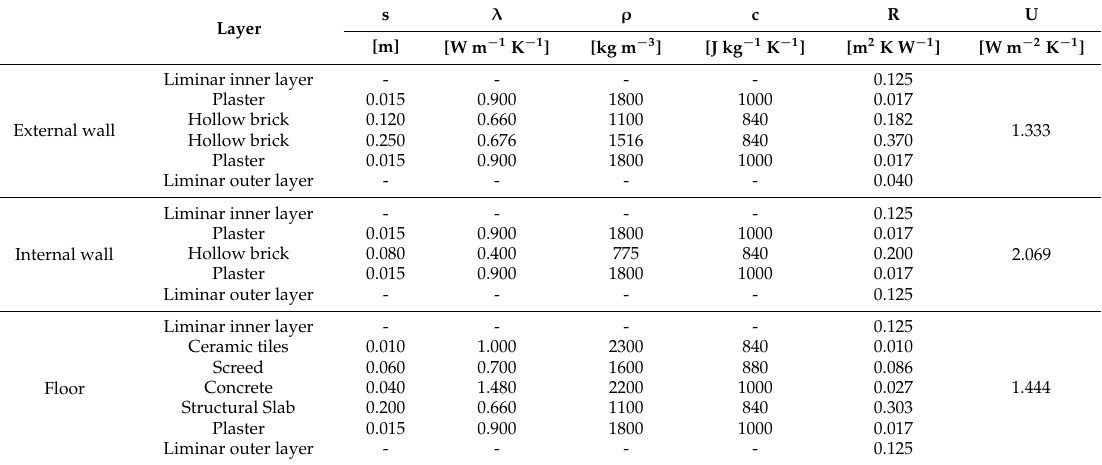
Table A1. Stratigraphy and thermal properties of the structures of the not insulated building (N).